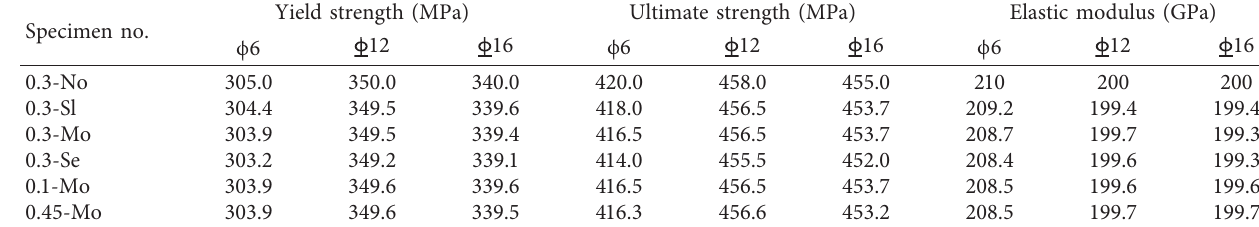
Table 4: Mechanical properties of corroded reinforcements.